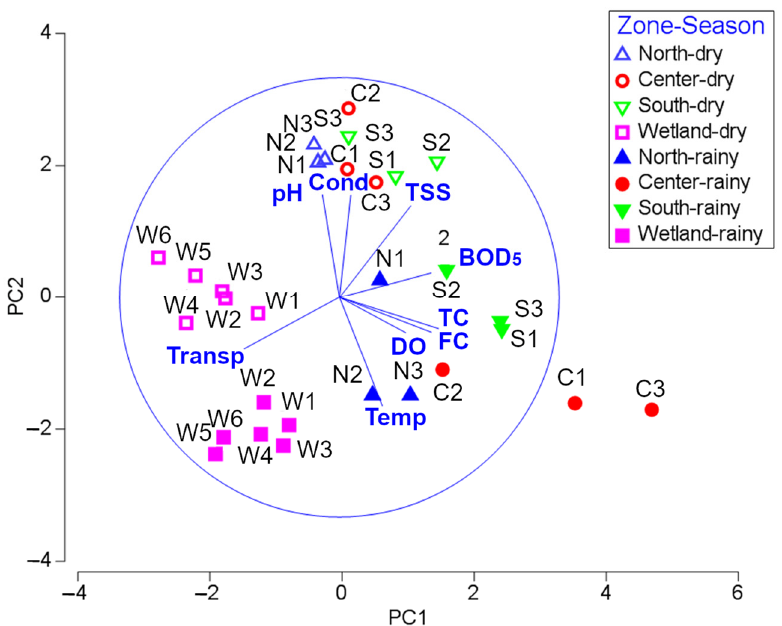
Figure 5. Bidimensional plot with the first two principal components obtained by principal com-